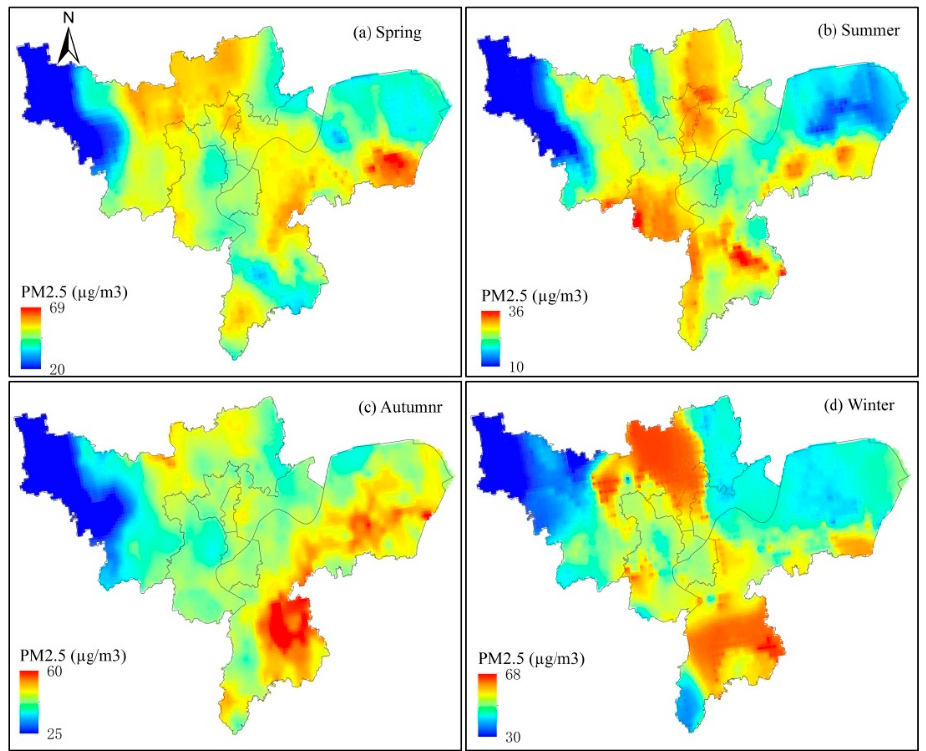
Figure 4. Spatial distributions of PM 2.5 concentrations during four seasons in Hangzhou. ( a ) Spring; ( b ) Summer; ( c ) Autumn; ( d ) Winter.